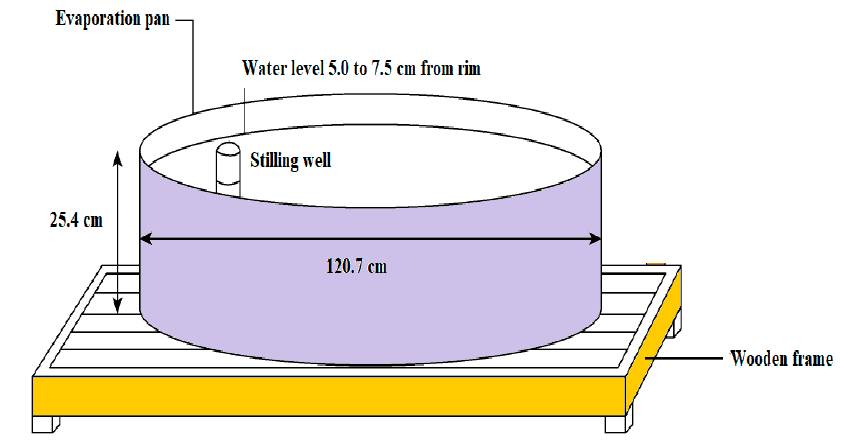
Figure 2. Standard U.S. weather bureau class A pan.